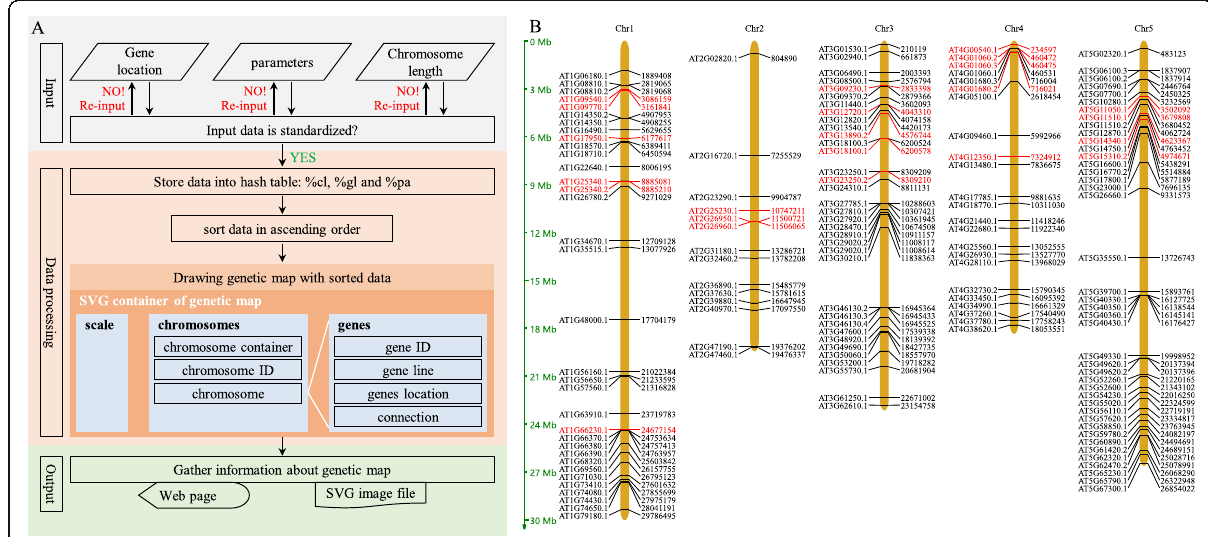
Fig. 1 A Workflow of MG2C. B The genetic map of MYB gene family from A . thaliana generated by